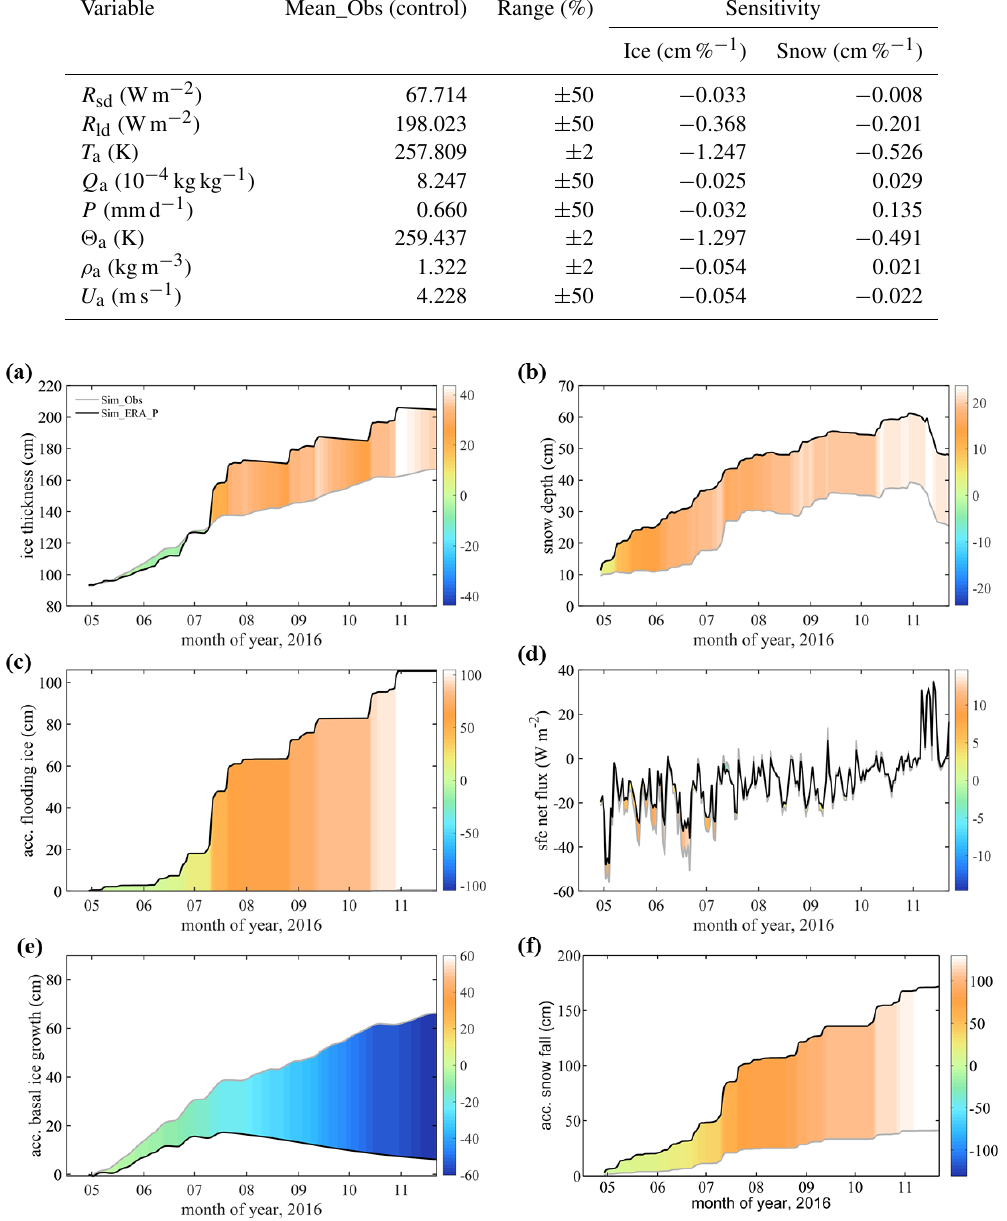
Figure 4. Times series of (a) sea ice thickness, (b) snow depth, (c) accumulated flood ice, (d) net surface heat flux, (e) accumu- lated basal ice growth, and (f) accumulated snowfall. The gray line represents the simulation using precipitation from observations (Sim_Obs). The black line represents the simulation using precipitation from ERA5 (Sim_ERA_P). The color bar represents their differ- ence (Sim_ERA_P −